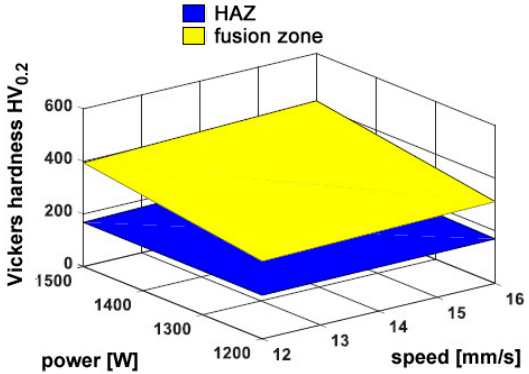
Figure 10. Example of the trend of Vickers micro-hardness in condition F; flat deposition.